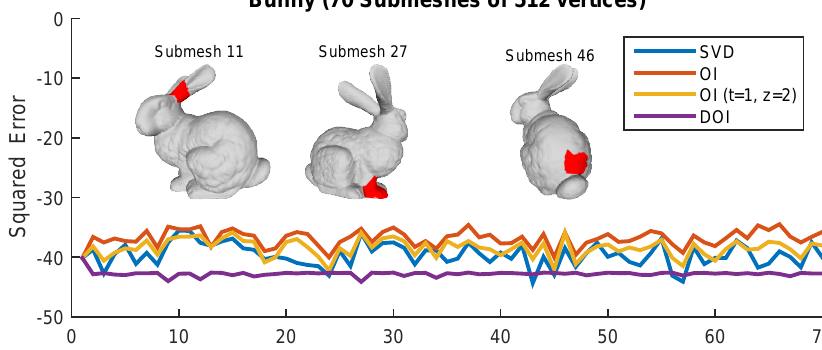
Figure 13. Squared error per each submesh for different approaches.